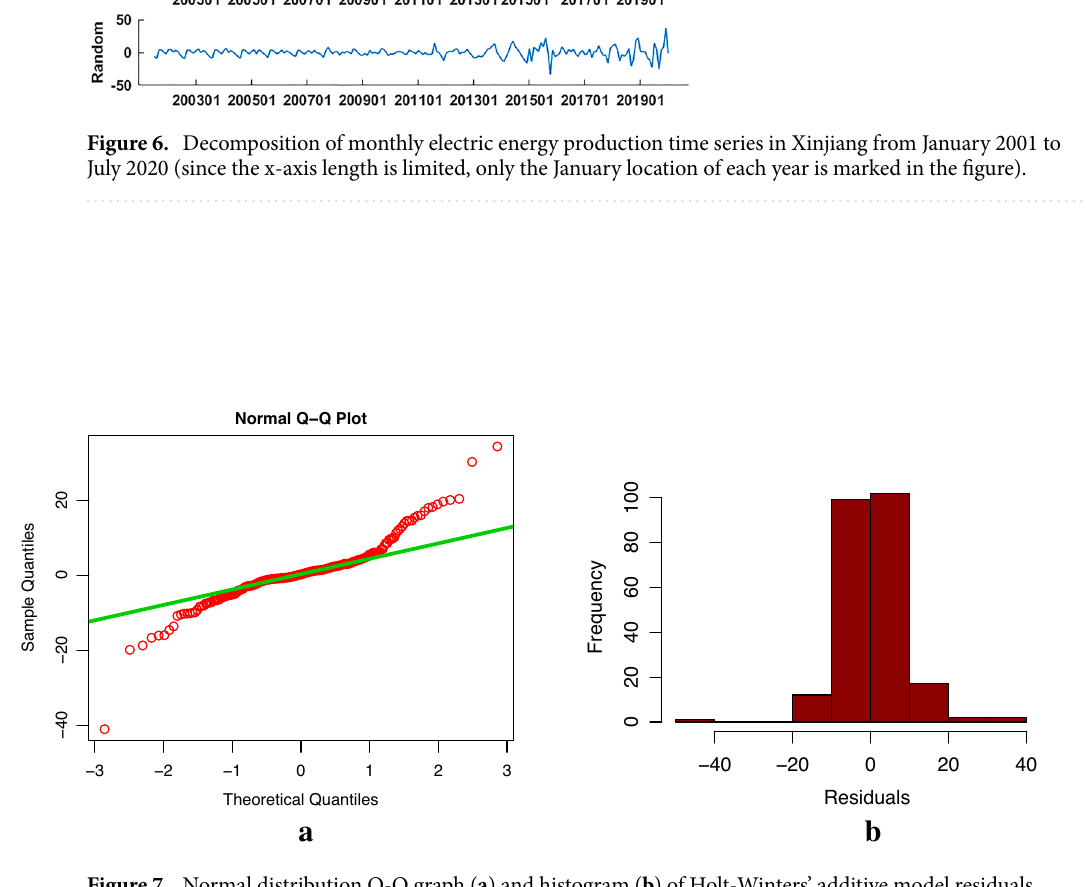
Figure 7. Normal distribution Q-Q graph ( a ) and histogram ( b ) of Holt-Winters’ additive model